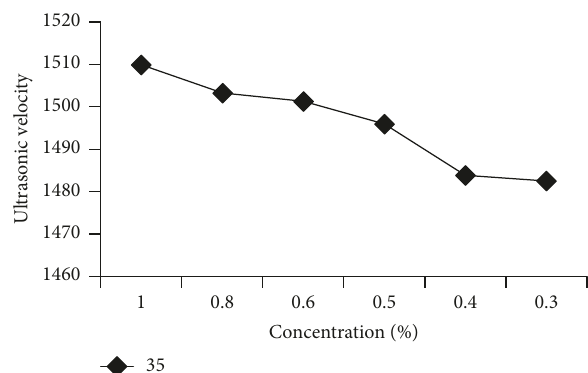
Figure 3: Variation of ultrasonic velocity with concentration at v35 ∘ C temperature.